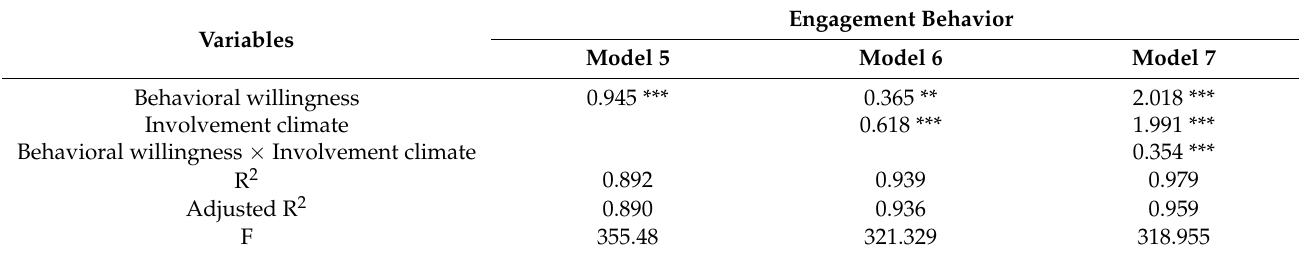
Table 9. Test for moderating effect of involvement